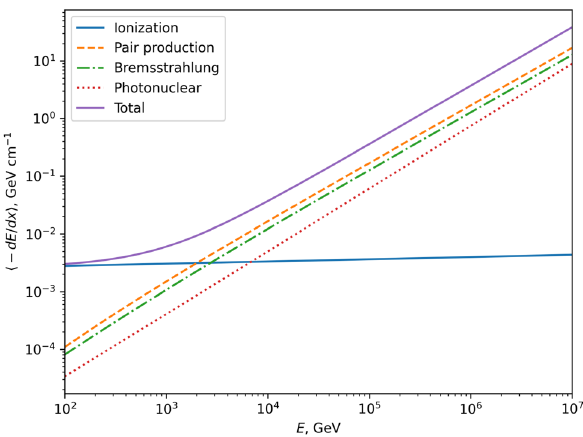
Fig. 1 Average energy loss of muons per distance in